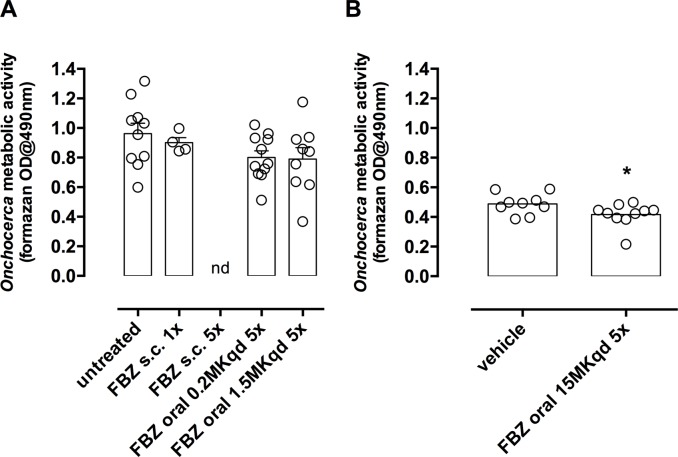
Average O. ochengi metabolic activity per mouse where motile worms were present, five weeks post-dosing with indicated treatments for experiment A (A) or B (B). Data points are mean formazan optical densities @490nm from worms recovered from each animal. Bars are mean +/-SEM per treatment group. Variation between untreated and treatment groups in experiment A was not significantly different (1way ANOVA). Metabolic activity was significantly reduced following FBZ oral 15mg/kg qd x 5 days (Unpaired T-test, *P<0.05) in experiment B.